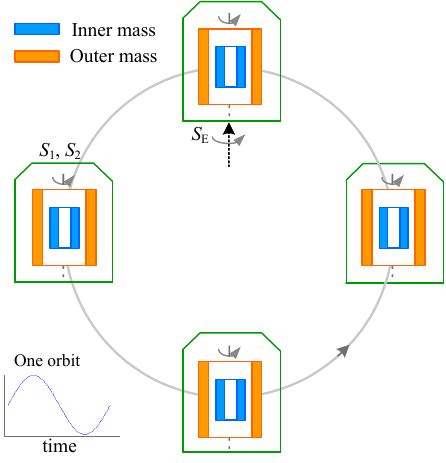
Figure 1. Concept of the space-station test of gravitational effects of two concentric rotating masses made of the same material. The cylindrical inner/outer test masses are suspended electrostatically in a differential accelerometer and spinning with much different angular momenta.